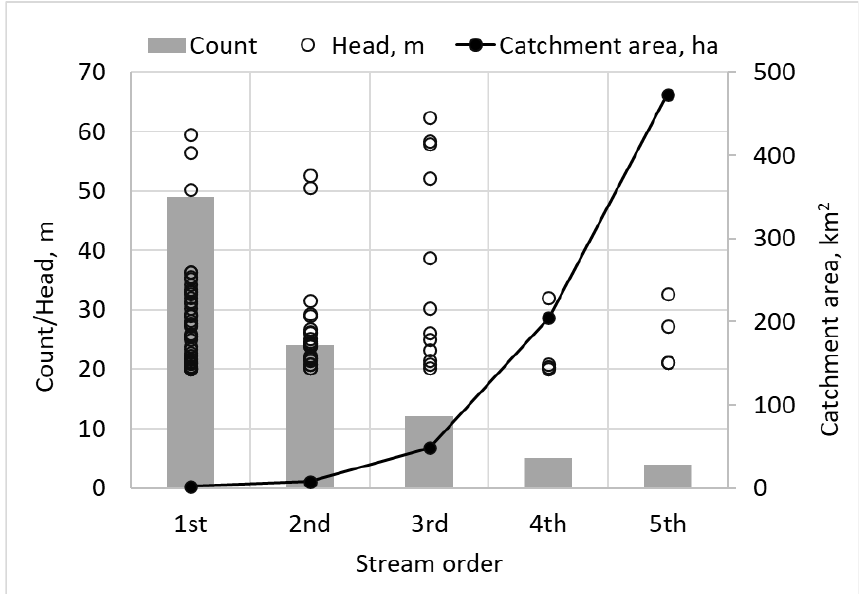
Figure 8. The number of sites, elevation head, and average catchment area of the identified potential small-scale hydropower sites under different stream orders.